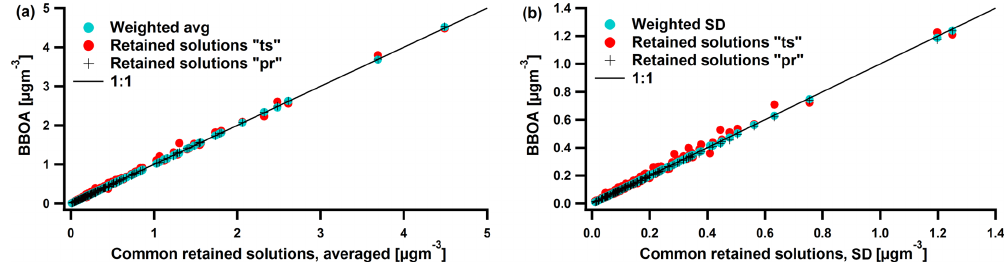
Figure 5. (a) Scatterplots between BBOA time series averaged (avg) over the common solutions coming from both the time series (ts) and profile (pr) sorting method plotted in the x axis, and plotted in the y axis the BBOA time series averaged over the solutions coming from the ts method in red, from the pr in black cross and from the weighted average based on the marker (here levoglucosan, in blue). The respective scatterplot for the standard deviation (SD) is shown in (b) .